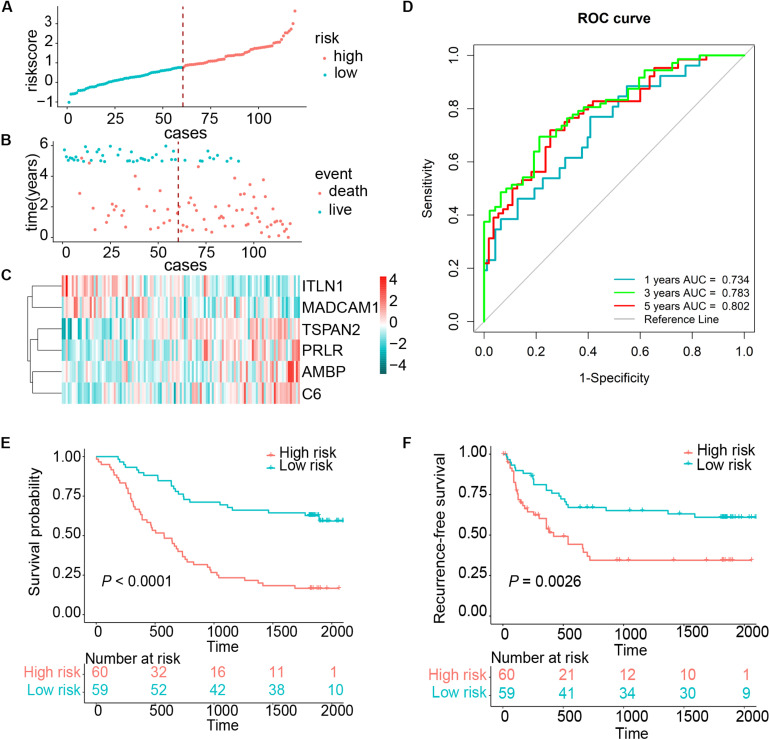
Risk score distribution and survival of patients in the training cohort. (A) The risk scores for 119 patients of the training cohort (GSE53624). (B) The survival of each patient in the training cohort (GSE53624). (C) Expression distribution of the six genes in the training cohort, with red indicating higher expression and blue indicating lower expression. (D) ROC analysis of immune-related genes signature for prediction of survival at 1, 3, and 5 years in the training cohort. (E,F) Kaplan–Meier curves of OS and RFS in 119 patients of the training cohort based on risk score, respectively.